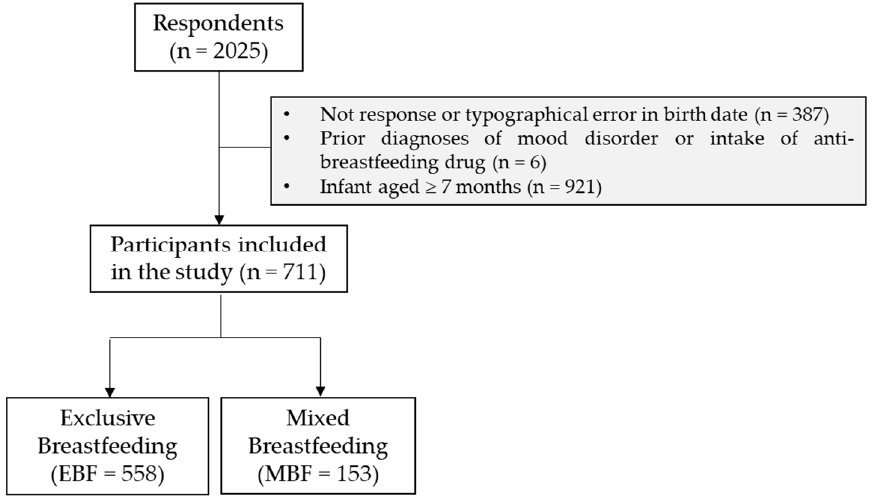
Figure 1. Flow-chart of the responses of the survey and sample size used in the study that match with the inclusion criteria.